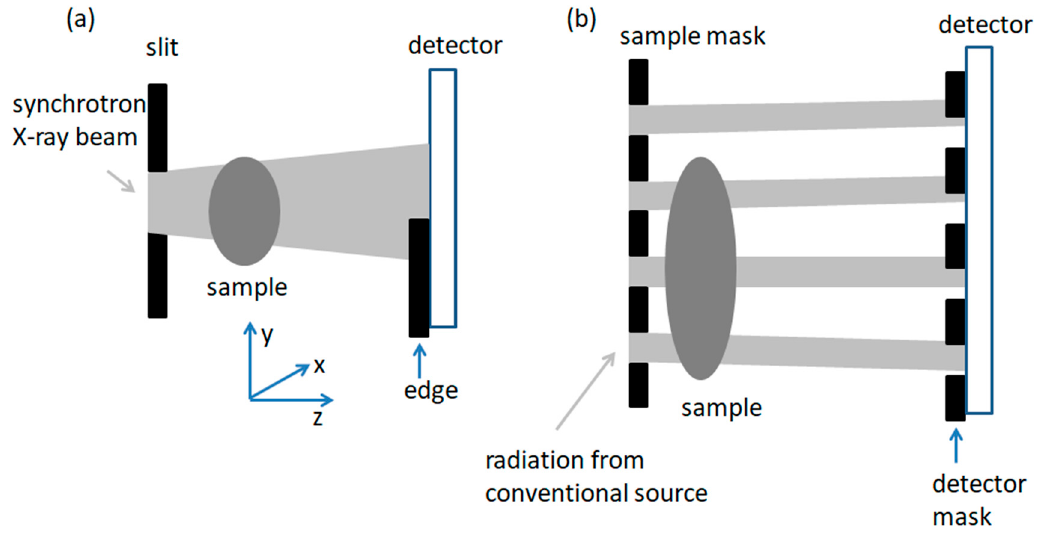
Figure 15. Sketch of the edge illumination setup. ( a ) Edge illumination (EI) method with synchrotron radiation. ( b ) EI method with conventional X-ray source.